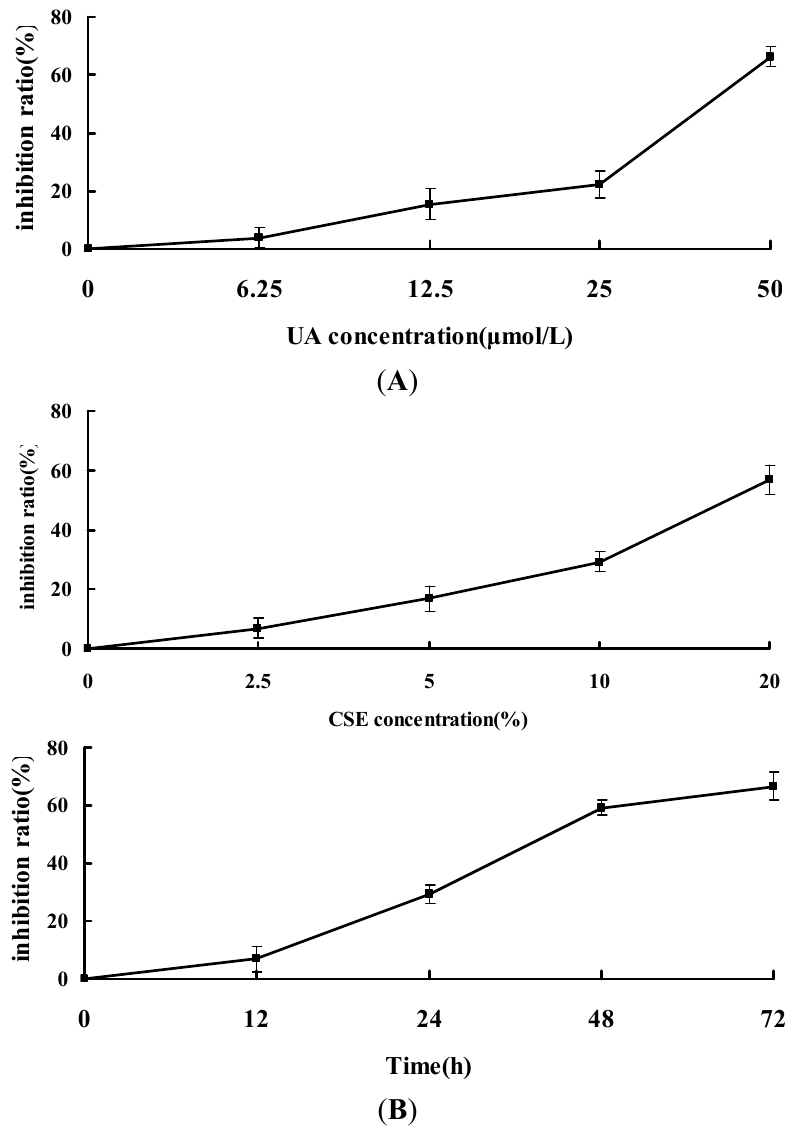
Figure 1. Cytoprotective effect of UA against CSE. ( A ) Effects of different concentrations of UA on NHBE cell proliferation; ( B ) Effects of different concentrations and treated time of CSE on NHBE cell proliferation; ( C – E ) Protective effect of UA determined through ( C ) MTT assay; ( D ) morphological examination; and ( E ) lactate dehydrogenase release. Values are expressed as mean ± SEM (n = 5). * p < 0.05, ** p < 0.01 vs . CSE